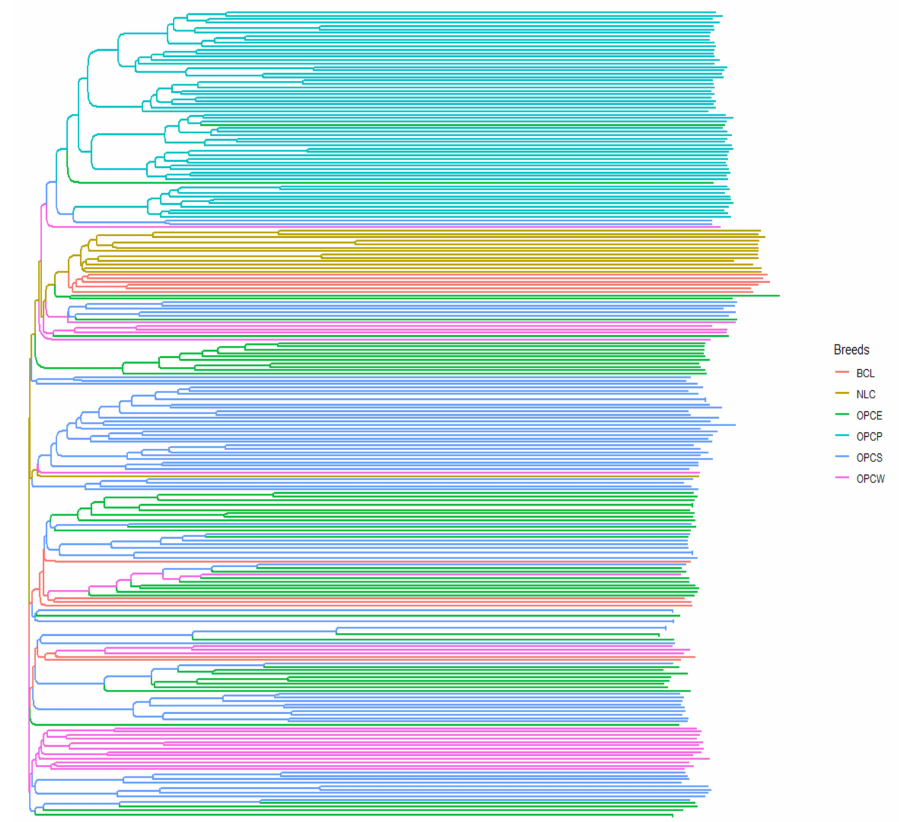
Figure 7. Dendrogram of individual pairwise genetic